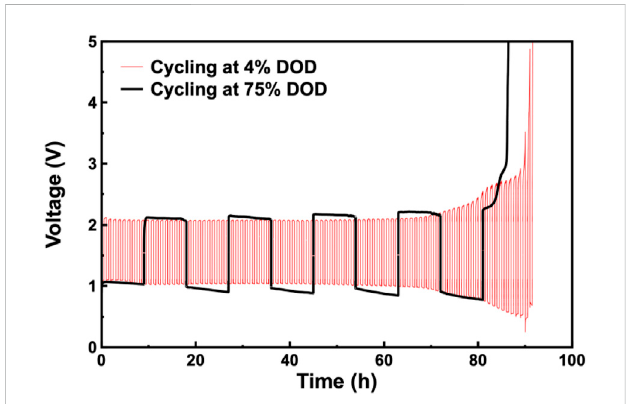
FIGURE 4 Galvanostatic charge/discharge cycle curves for assembled ZABs cycling respectively at 4% and 75% DOD, respectively.